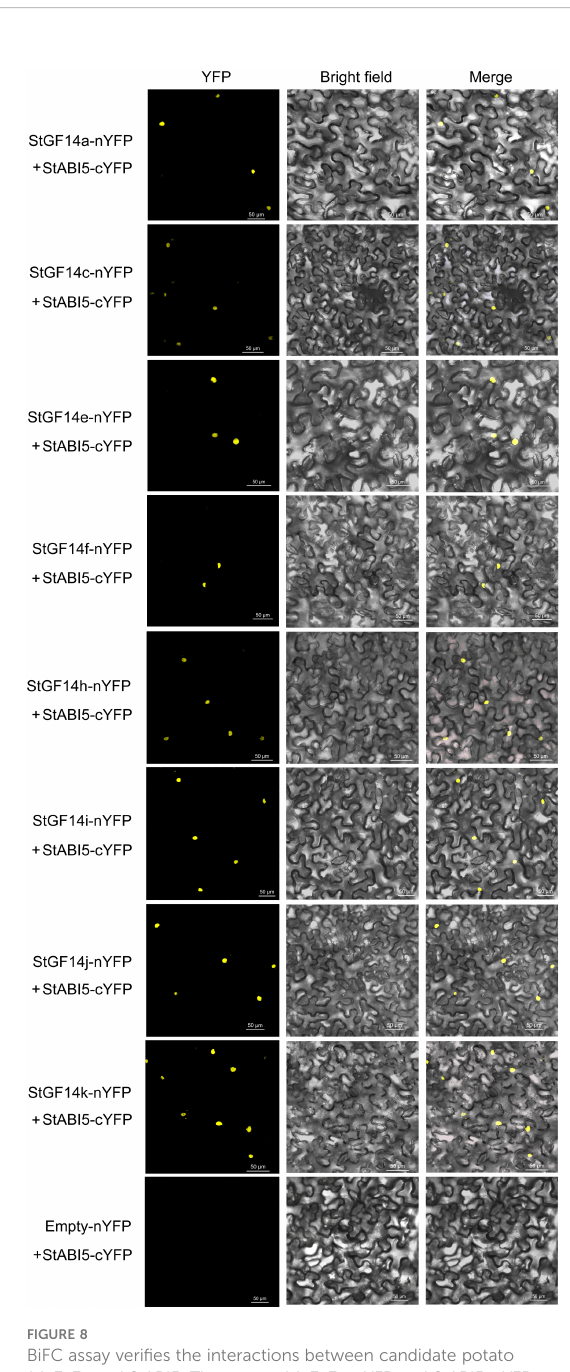
FIGURE 8 BiFC assay veri fi es the interactions between candidate potato 14-3-3s and StABI5. The potato 14-3-3s-nYFP and StABI5-cYFP vectors are transient transformed in tobacco leaves determined. Yellow fl uorescent protein (YFP) images are detected in nulceus of tobacco leaf epidermal cells, indicating the interaction between potato 14-3-3s and StABI5. Bars = 50 m